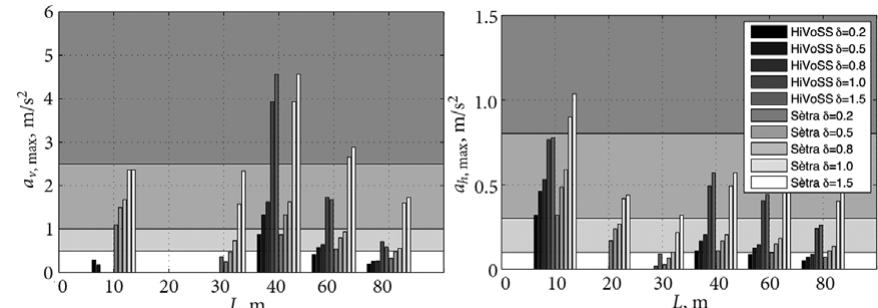
Fig. 14. Vertical and lateral accelerations induced by a flow of walkers: variable density